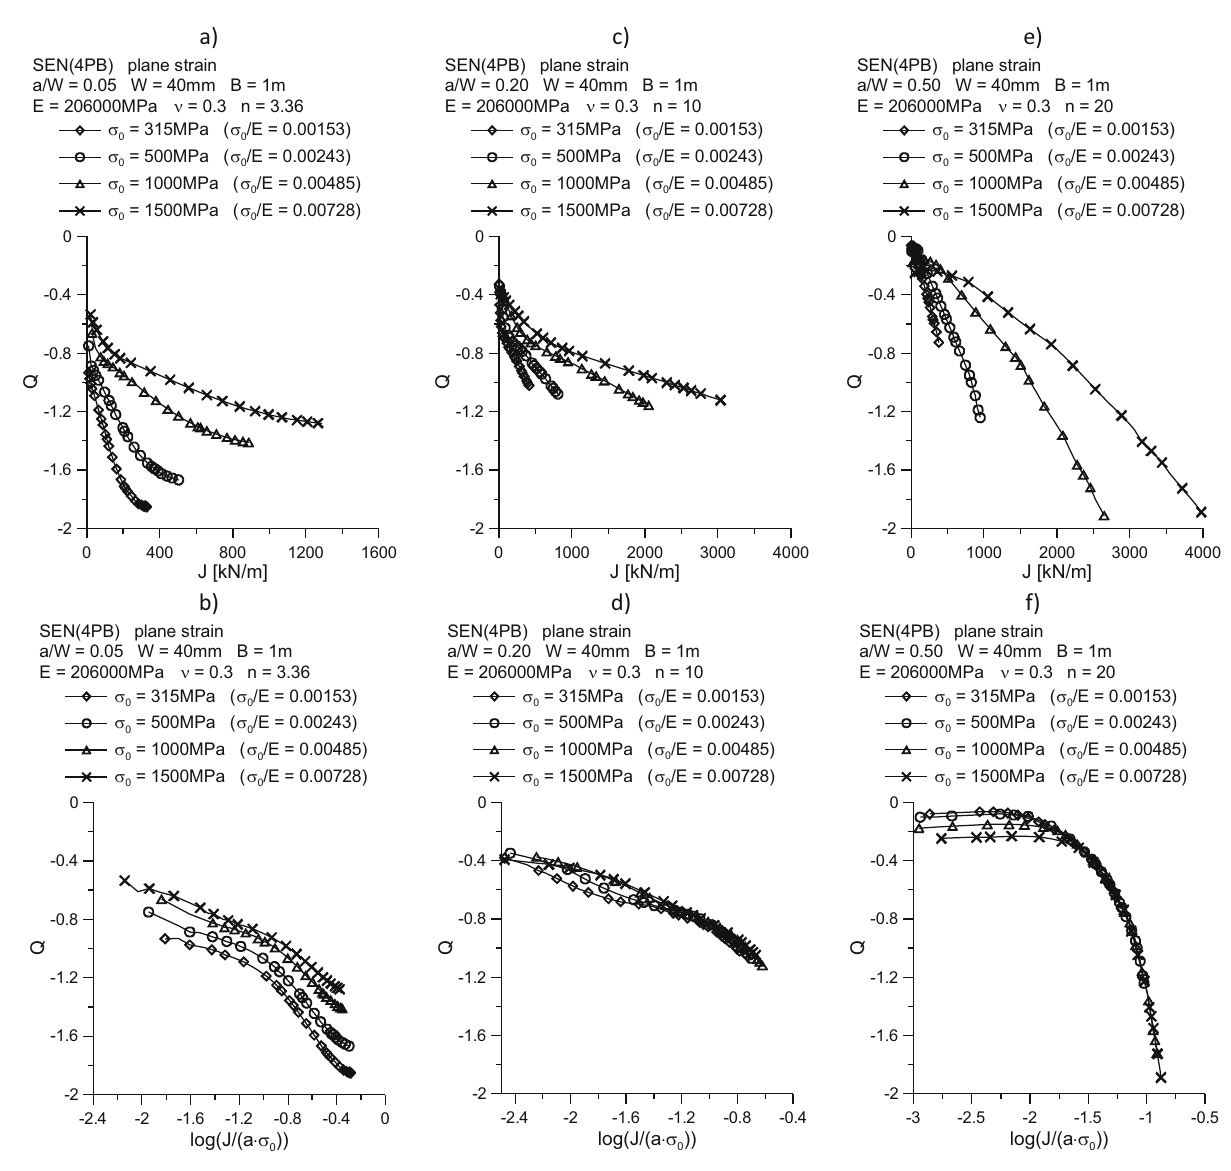
Figure 26: In fl uence of the yield point σ 0 on the distribution of the Q = f ( J ) and Q = f ( log ( J / ( a · σ 0 ))) curves for SEN ( 4PB ) specimens dominated by the plane strain state: ( a and b ) n = 3.36, a / W = 0.05; ( c and d ) n = 10, a / W = 0.20; ( e and f ) n = 20, a / W =